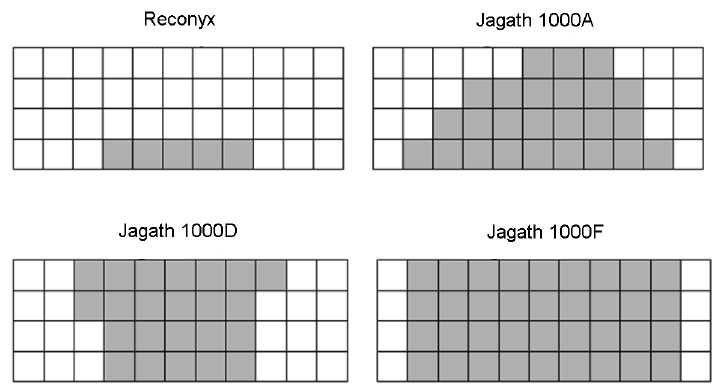
Figure 2. The detection zone of each camera, tested at a distance of 1 m. Shaded squares represent 10 × 10-cm grid squares in which movement triggered the